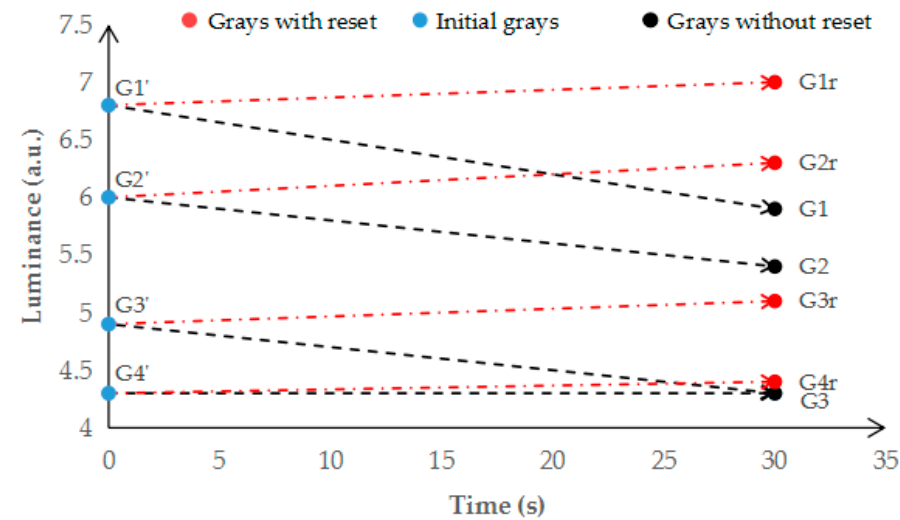
Figure 7. Grayscales affected by oil backflow. The luminance of four grayscales decreased after 30 s. After 30 s, the luminance of G3 ′ was the same as G4 ′ . The initial luminance of grayscales was G1 ′ , G2 ′ , G3 ′ , and G4 ′ . After 30 s, the grayscales without the reset waveform ere changed to G1, G2, and G3, and grayscales with the reset waveform changed to G1r, G2r, G3r, and G4r.